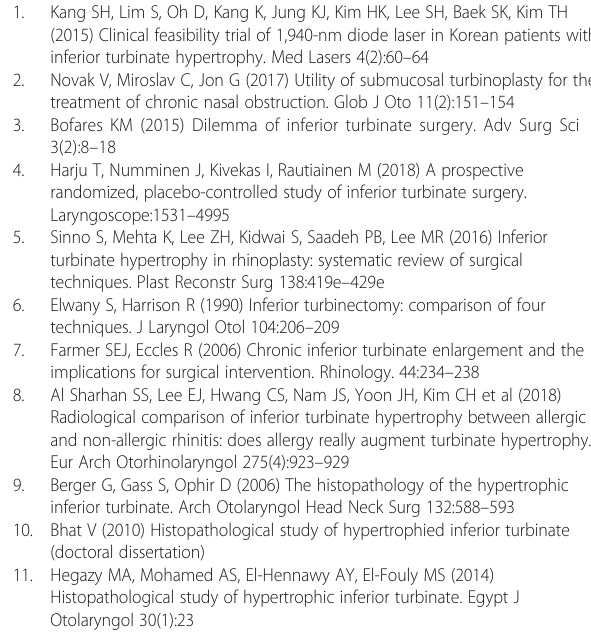
Table 5 Complications according to procedures performed Complications according to procedures performed